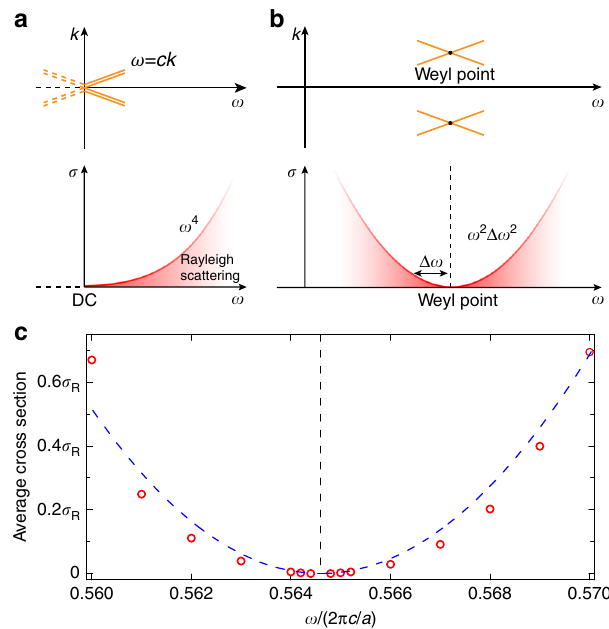
Fig. 5 Rayleigh scattering in free space and Weyl systems. a In free space, the Rayleigh scattering cross section scales as σ (cid:2) ω 4 and vanishes at the DC frequency. b In Weyl systems, the Rayleigh scattering cross section scales as σ (cid:2) ω 2 Δ ω 2 and vanishes at the Weyl frequency, which is indicated by the black dashed line. In both a and b , regions with stronger red colours indicate smaller Rayleigh scattering cross section. c Numerical calculation of Rayleigh scattering in a Weyl photonic crystal. The Rayleigh scatterer is a dielectric sphere with a radius of 0.01 a and a dielectric constant of 2. The numerical results (red circles) are normalized by the Rayleigh scattering cross section in free space σ R , and fi t well the predicted σ (cid:2) ω 2 Δ ω 2 scaling (blue dashed line). The black dashed line also indicates the Weyl